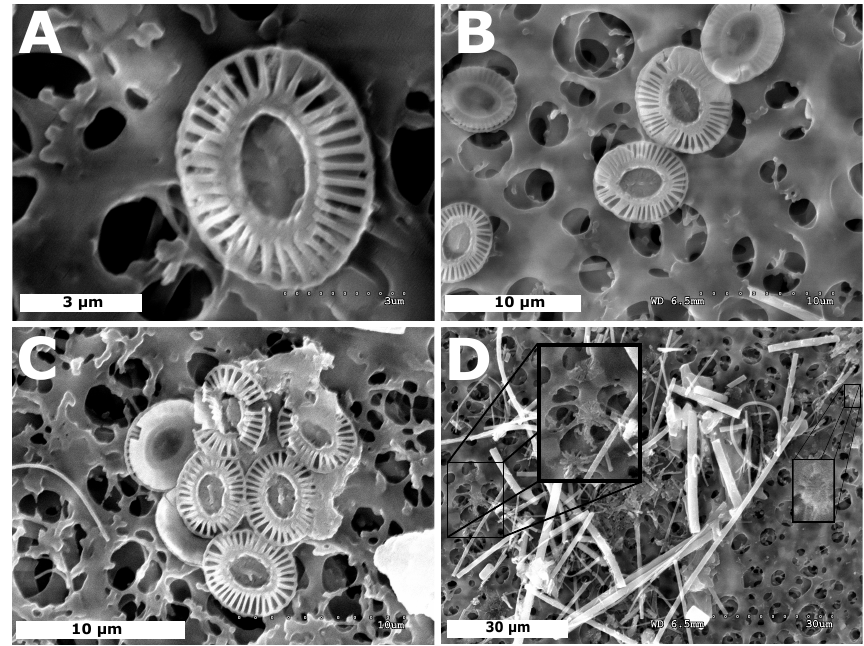
Fig. 5. SEM pictures of E. huxleyi cultures from the batch (A–C) and chemostat (D) experiments. Displayed are coccoliths produced by E. huxleyi exposed to a p CO 2 of (A) 282 ± 21µatm, (B) 442 ± 15µatm and (C) 1077 ± 165µatm. (D) Example from the chemostat experiments indicating disintegrated coccoliths (within the black rectangles) due to storage problems (see text for details).